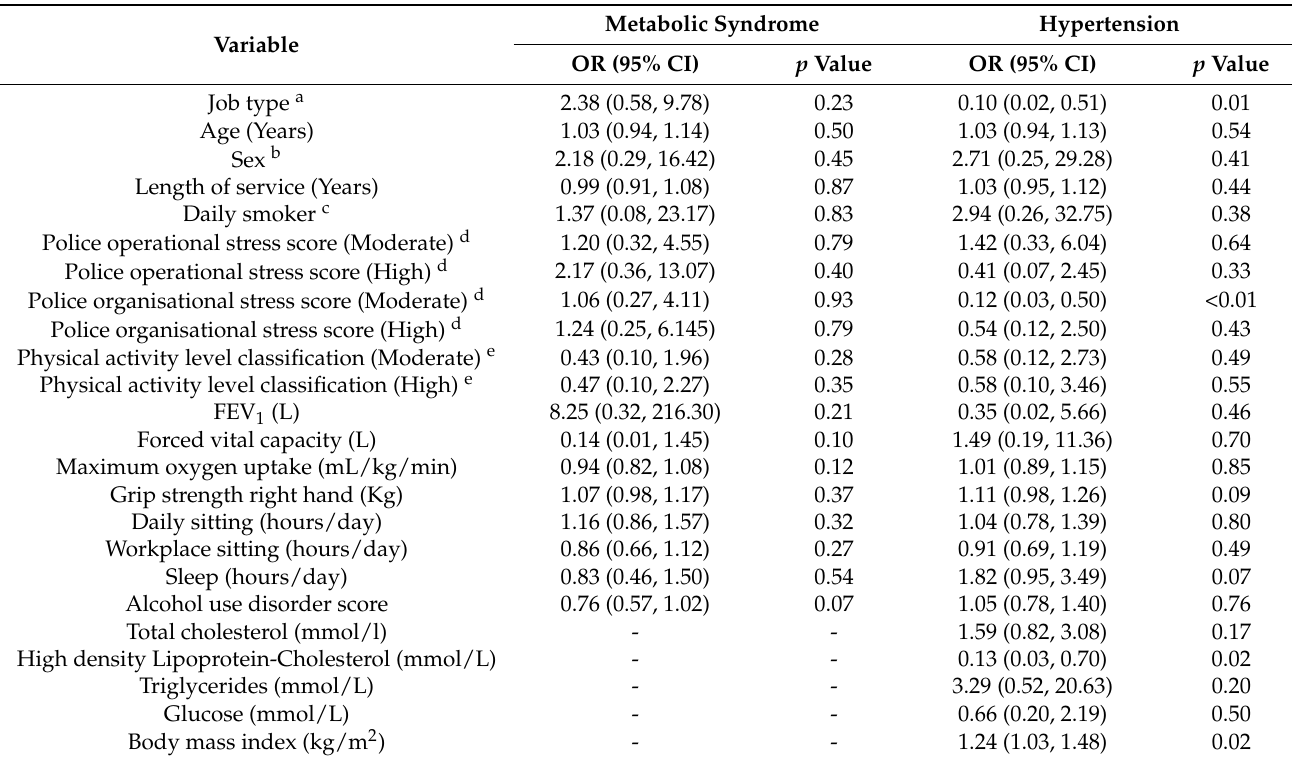
Table 5. Odds ratios for metabolic syndrome and hypertension according to each predictor variable ( n =